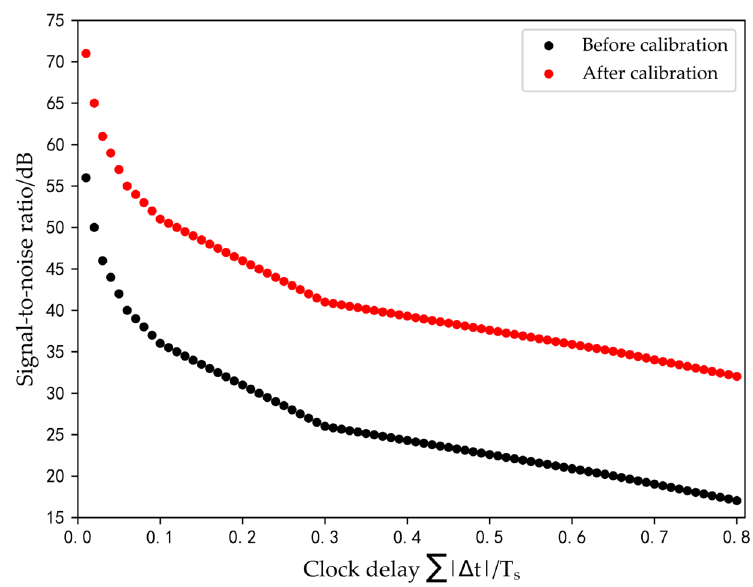
Figure 9. Changes in SINAD for a four-channel TIADC.